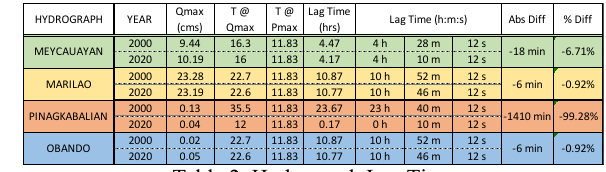
Table 2. Hydrograph Lag Time